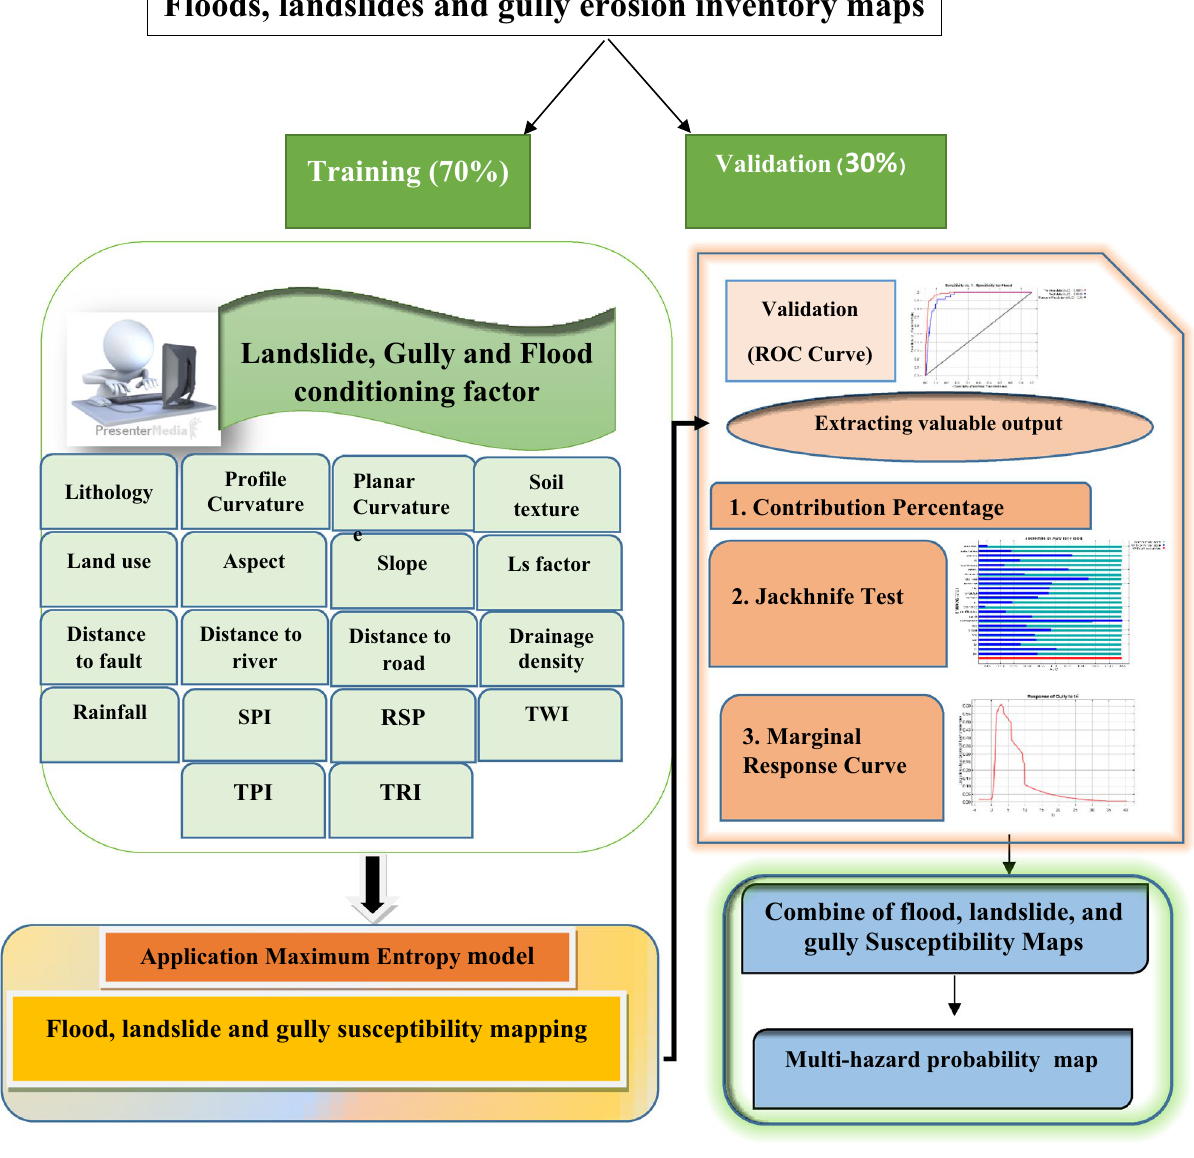
Figure 3. Flowchart of the methodology used for the MHPM in Gorganrood Watershed, Golestan Province, Iran. *Own